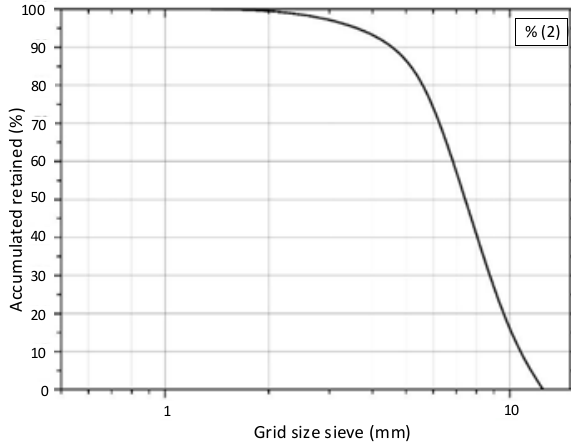
Figure 1. Distribution according to fine aggregate sieve.